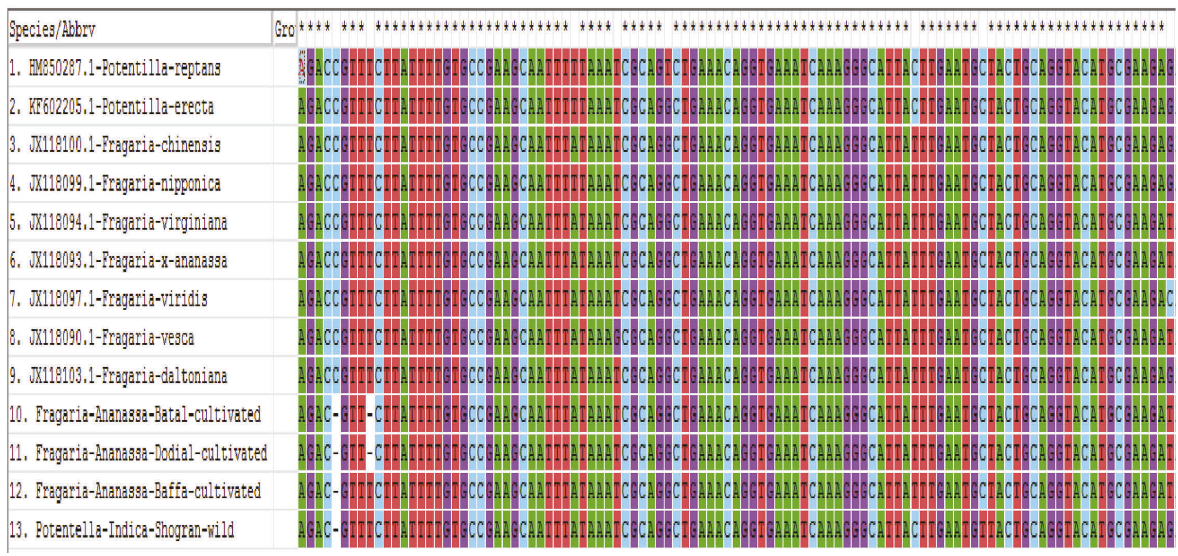
Figure 14: Basic local alignment of the selected Fragaria species ( rbclC ) marker with related reference sequences.